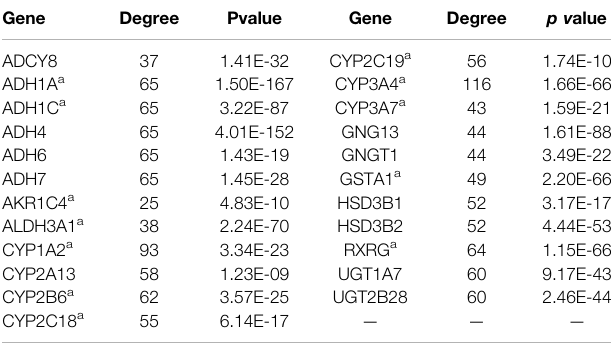
TABLE 2 | The candidate diagnostic markers for breast